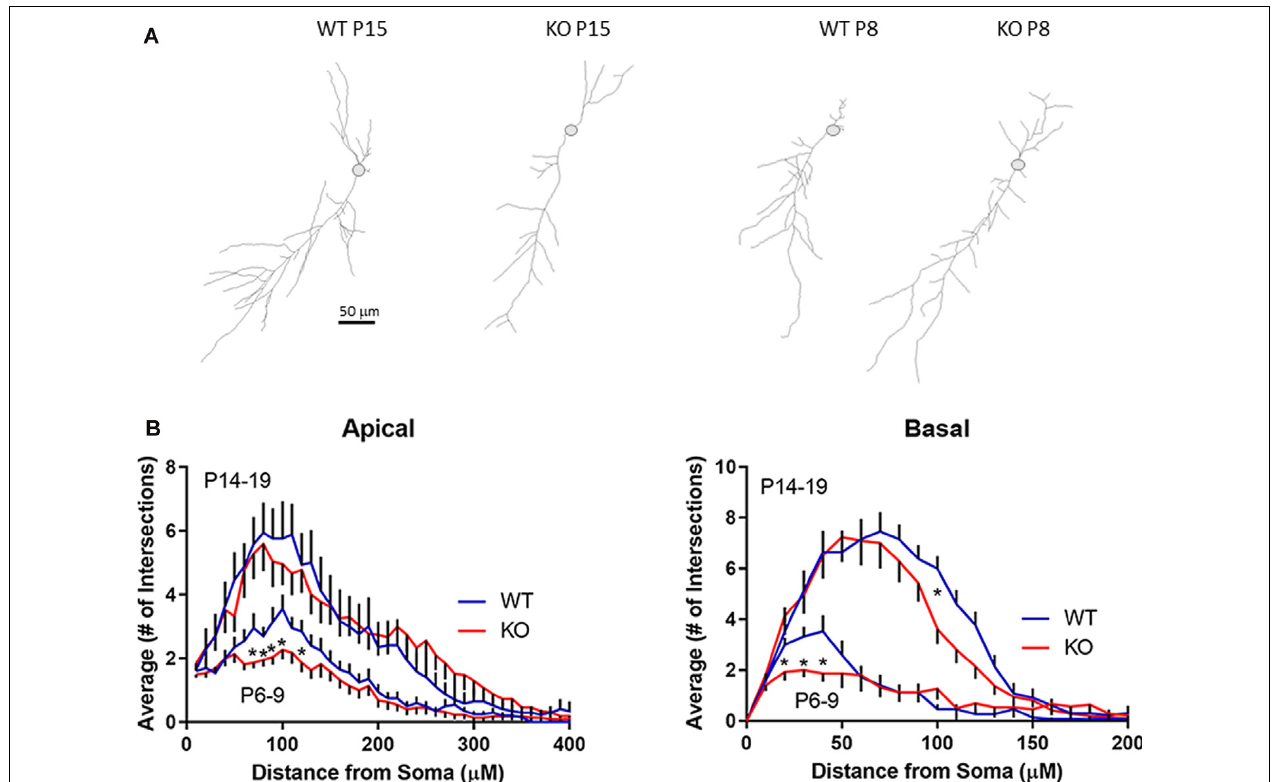
FIGURE 5 | Development of dendritic branching in FMRP KO CA1 neurons. (A) Examples of skeleton drawings of CA1 neurons from slices as indicated. Neurons were backfilled with biotin for post hoc morphological analysis. Scale bar = 50 µ m. (B) Sholl analysis indicating the average number of intersections of apical dendrites (left) or basal dendrites (right) with concentric circles spaced 10 µ m apart from P6–9 or P14–19 pyramidal neurons from either FMRP KO slices (red line; n = 23 and n = 27, respectively) or WT slices (blue line; n = 21 and n = 17, respectively). Asterisks indicate p < 0.05 t -test statistical significance when comparing WT and KO slices within a particular age